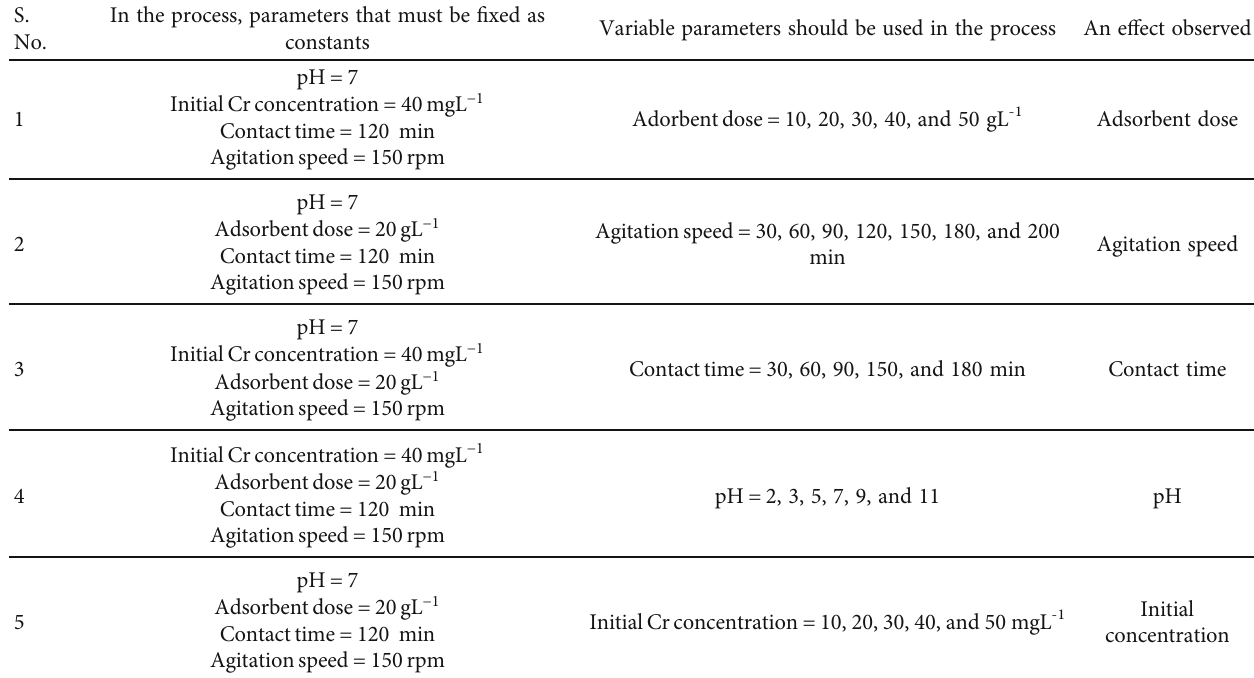
Table 1: Optimization of the e ff ect of pH, contact time, agitation speed, adsorbent dose, and initial concentration of Cr at room